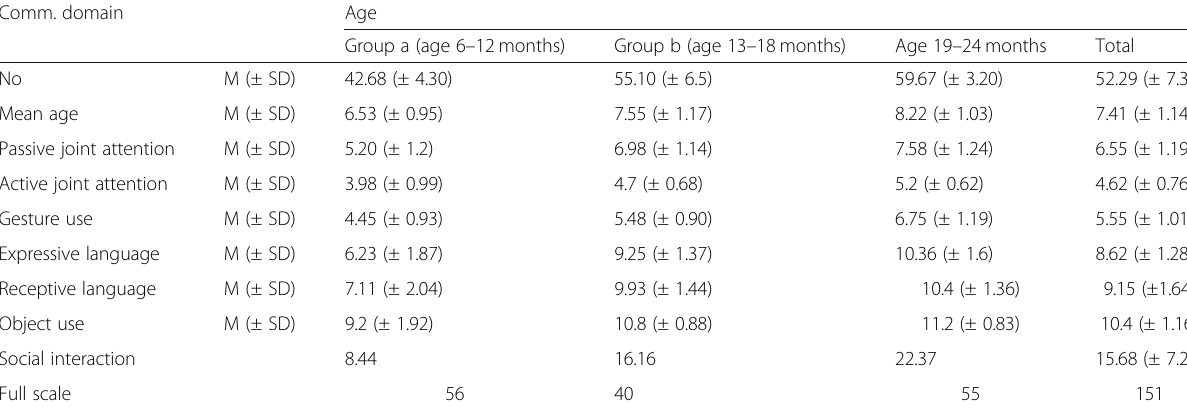
Table 7 The mean values scored by children in each domain in the three subgroups Comm.